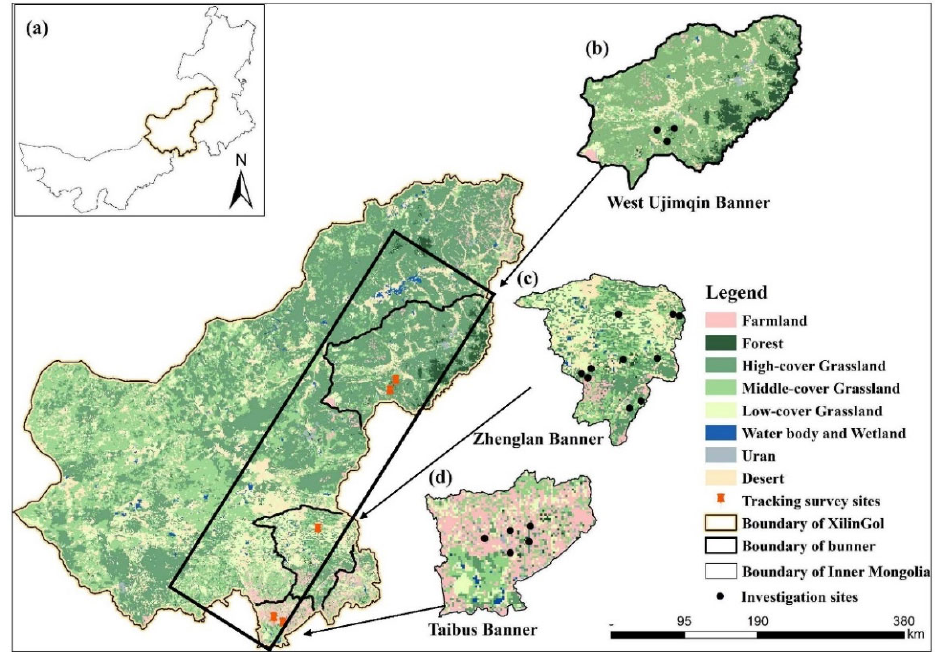
Figure 1. Location of the study area. ( a ) Inner Mongolia, ( b ) West Ujimqin Banner, ( c ) Zhenglan Banner, ( d ) Taibus Banner. Data resources: Location data were obtained from the Global Positioning System (GPS) when we took household interview and land use data, which were obtained from the Resource and Environment Science and Data Center (http://www.resdc.cn, accessed on 2 August 2022).